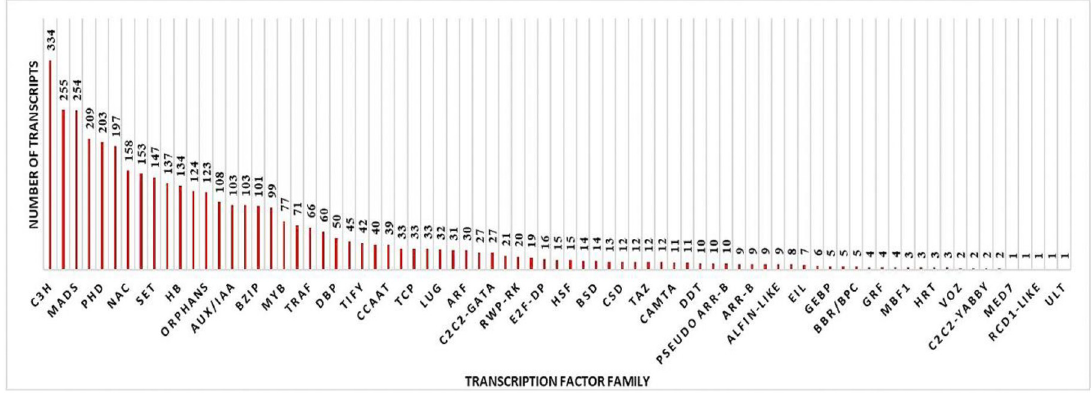
Fig 3. Distribution of L . tridentata transcripts in different transcription factor